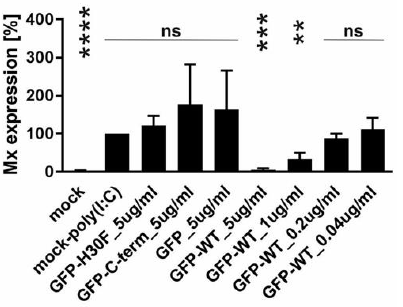
Figure 7. Ability of GFP-E rns fusion proteins to inhibit dsRNA-induced Mx expression. Quantification of the signal intensities of poly(IC)-induced Mx expression was performed as described for Figure 6 with GFP fused to wt E rns (GFP-wt) or to E rns -H30F (GFP-H30F), GFP fused to the C-terminal 37 amino acids of E rns (GFP-C-term) and GFP alone at the concentrations as indicated. Statistical analysis was performed with the mean of four independent experiments of every sample compared to H30F at 5 ng/ µ L as described in Figure 6. **** ( p < 0.0001), *** ( p < 0.001), ** ( p < 0.01), ns (not